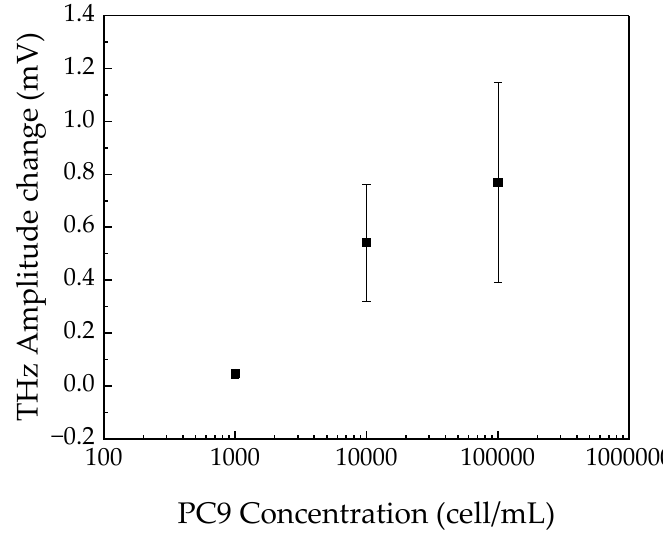
Figure 6. Average value of change in terahertz amplitude for each well in the black rectangles shown in Figure 5 as a function of the concentration of PC9 in solution. The error bar is the standard deviation for the data obtained by three independent sensing plates. The vertical axis was offset by fitting the data.